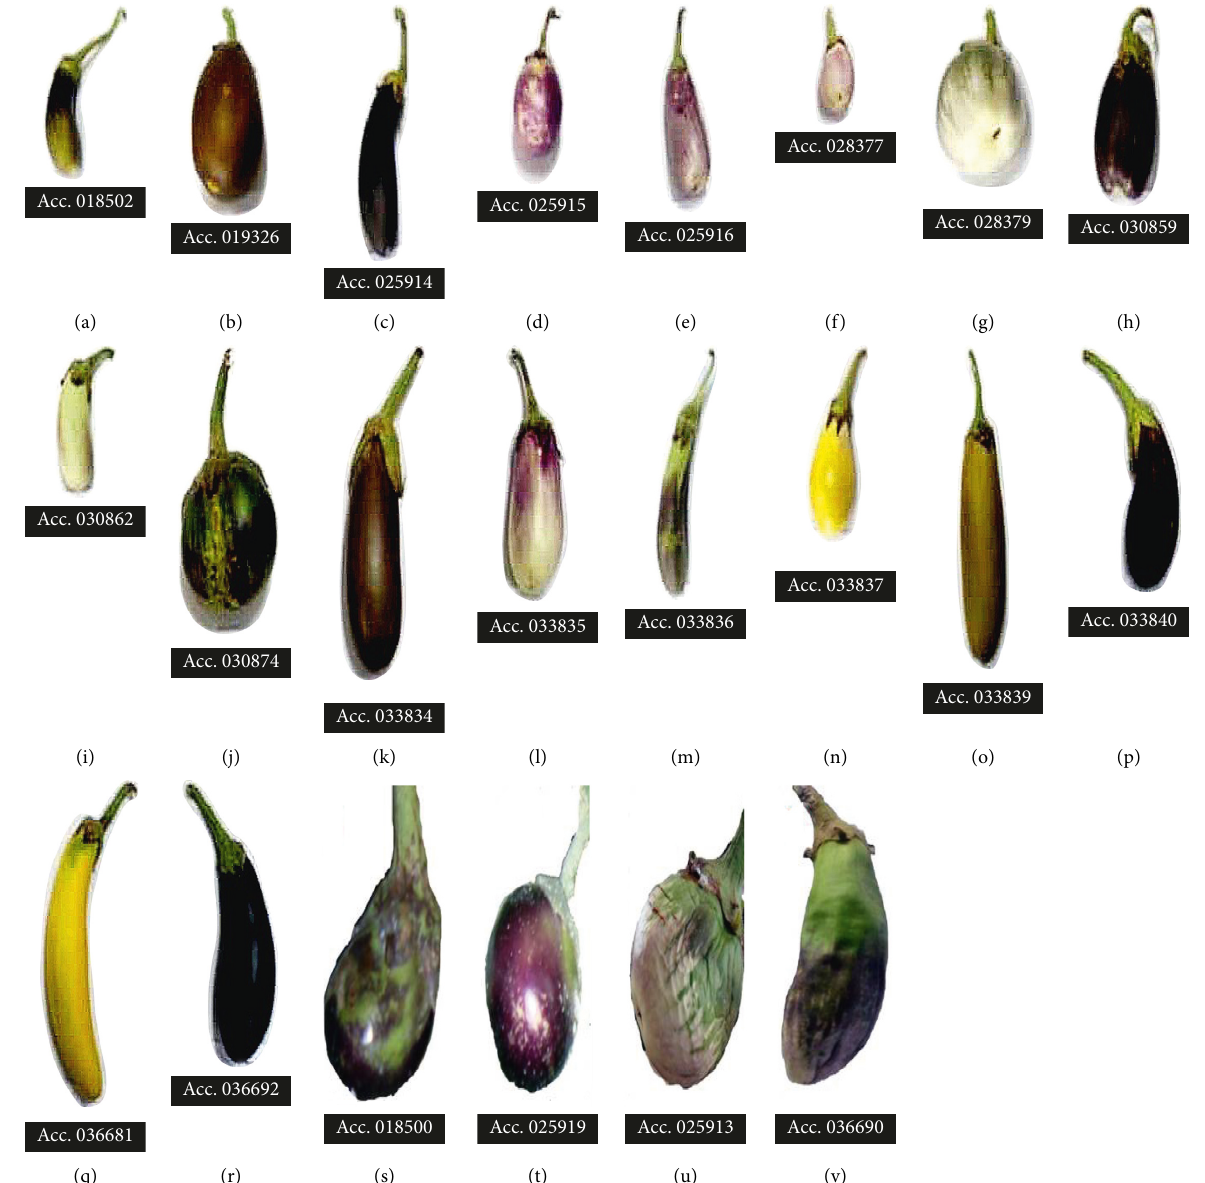
Figure 4: The variation in morphological characters among 22 different eggplant accessions. (a) Eggplant PP-Long (Acc. No 018502). (b) Eggplant variety 004467(17) (Acc. No 019326). (c) Eggplant Xaiangzue-6 (Acc. No 025914). (d) Eggplant white egg (Acc. No 025915). (e) Eggplant A-58 (Acc. No 025916). (f) Eggplant BARI-1 Acc. (No 028377). (g) Eggplant variety 004729 (01) with (Acc. No 028379). (h) Eggplant Badanjan (Acc. No 030859). (i) Eggplant Viserba (Acc. No 030862). (j) Eggplant variety PI 606711 (Acc. No 030874). (k) Eggplant Grif-13962 (Acc. No 033834). (l) Eggplant variety PI-362727 (Acc. No 033835). (m) Eggplant variety PI-371849 (Acc. No 033836). (n) Eggplant variety PI-379545-A (Acc. No 033837). (o) Eggplant variety PI-381288-A (Acc. No 033839). (p) Eggplant variety PI-381288-B (Acc. No 033840). (q) Eggplant variety 7655(4) (Acc. No 036631). (r) Eggplant variety 7657 (6) (Acc. No 036692). (s) Eggplant Black king (Acc. No 018500). (t) Eggplant variety 004464 (07) (Acc. No 025919). (u) Eggplant Mk-95 (Acc. No 025913). (v) Eggplant variety